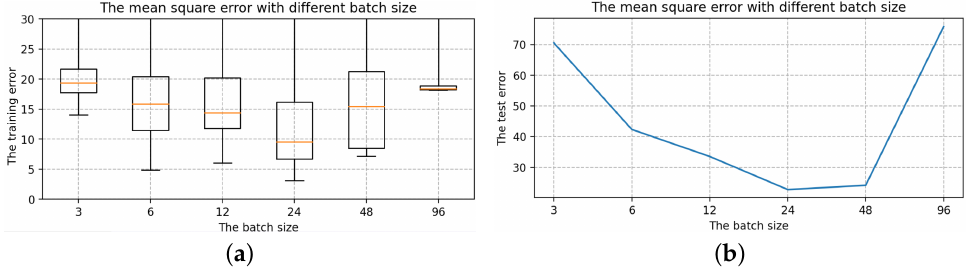
Figure 16. The mean square error with different batch sizes. ( a ) The training error with different batch sizes. ( b ) The test error with different batch sizes.